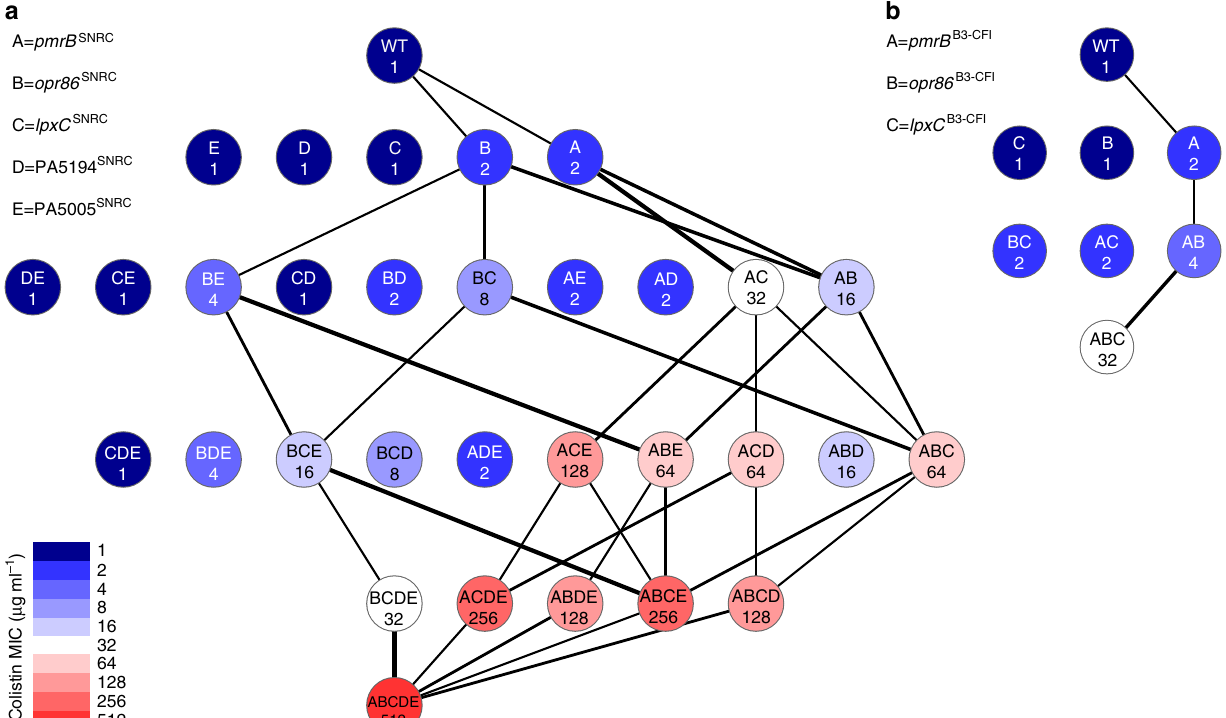
Figure 3 | Evolutionary pathways to colistin resistance. ( a ) Phenotypes of the 32 (2 5 ) constructed genotypes in PAO1 based on mutations linked to resistance in the colistin-resistant strain SNRC with colistin MIC ( m gml (cid:2) 1 ) for each genotype. ( b ) Phenotypes of the 8 (2 3 ) constructed genotypes in PAO1 based on the alleles of pmrAB 634G 4 A,742G 4 A ( pmrAB B3 (cid:2) CFI ), opr86 1525A 4 G ( opr86 B3 (cid:2) CFI ) and lpxC 551A 4 G ( lpxC B3 (cid:2) CFI ) linked to resistance in colistin- resistant strains from patient B3 (B3-20M and B3-CFI) with colistin MIC ( m gml (cid:2) 1 ) for each genotype. For both figures, node labels denote genes affected by the mutation. Blue, low colistin MIC; red, high colistin MIC. Line thickness indicates relative MIC increase. Paths to high-level resistance deemed inaccessible to selection because they had no increase in MIC at any step were omitted for clarity. Wildtype (WT), ancestral P. aeruginosa PAO1. Colistin MIC was determined by microbroth dilution assays and values are the median of at least three biological